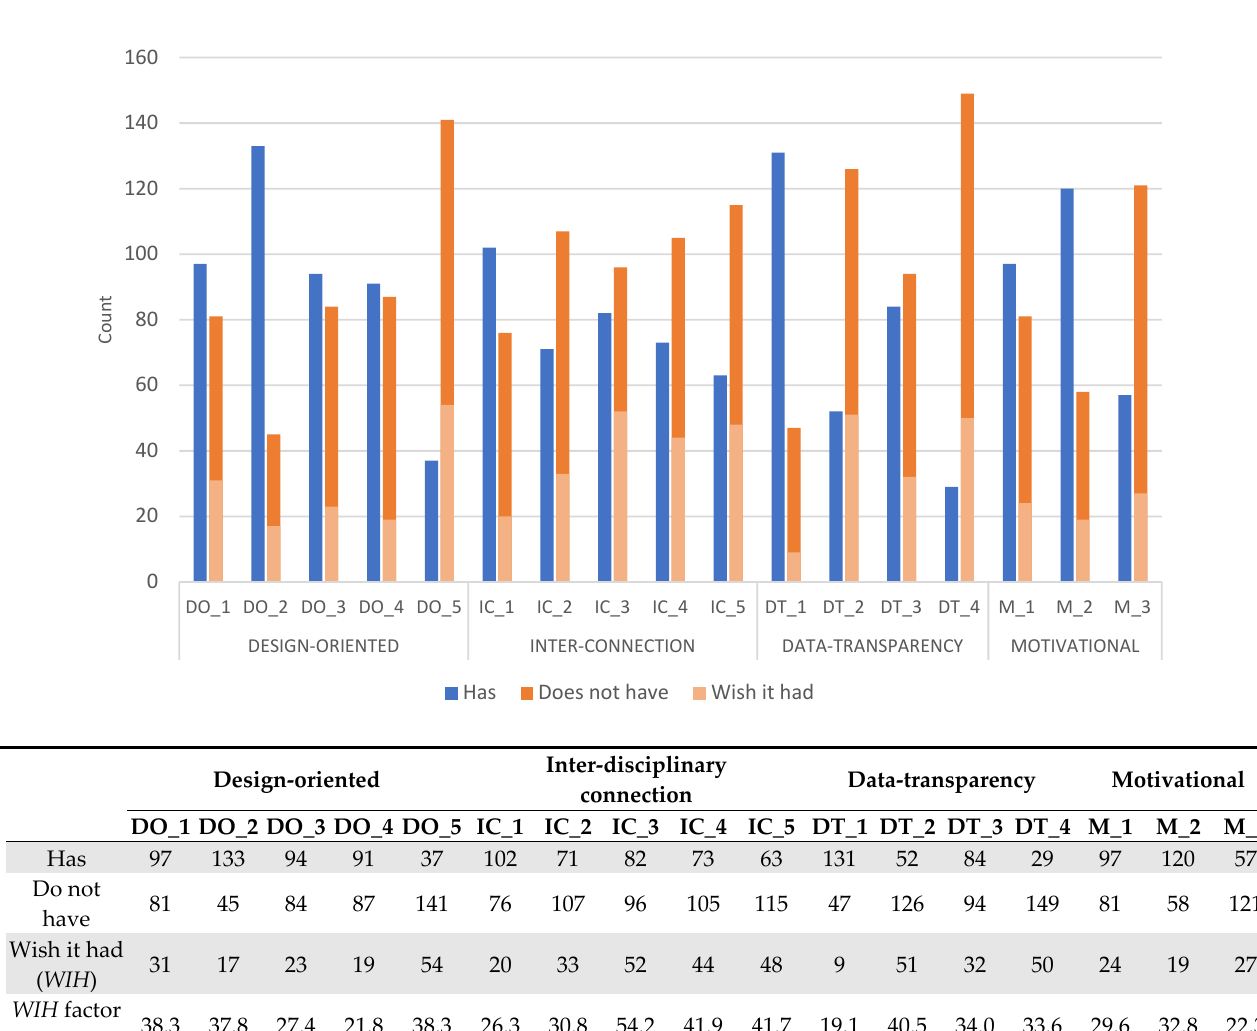
Figure 2. Total of participants that assigned whether the software tool has, does not have or wish it had the attribute.